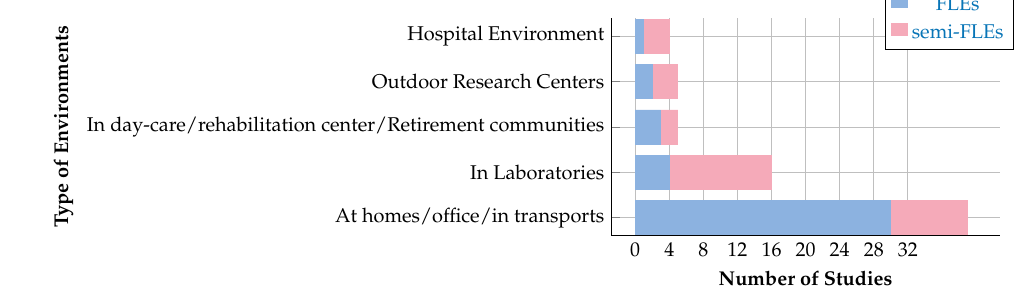
Figure 9. Details of the used